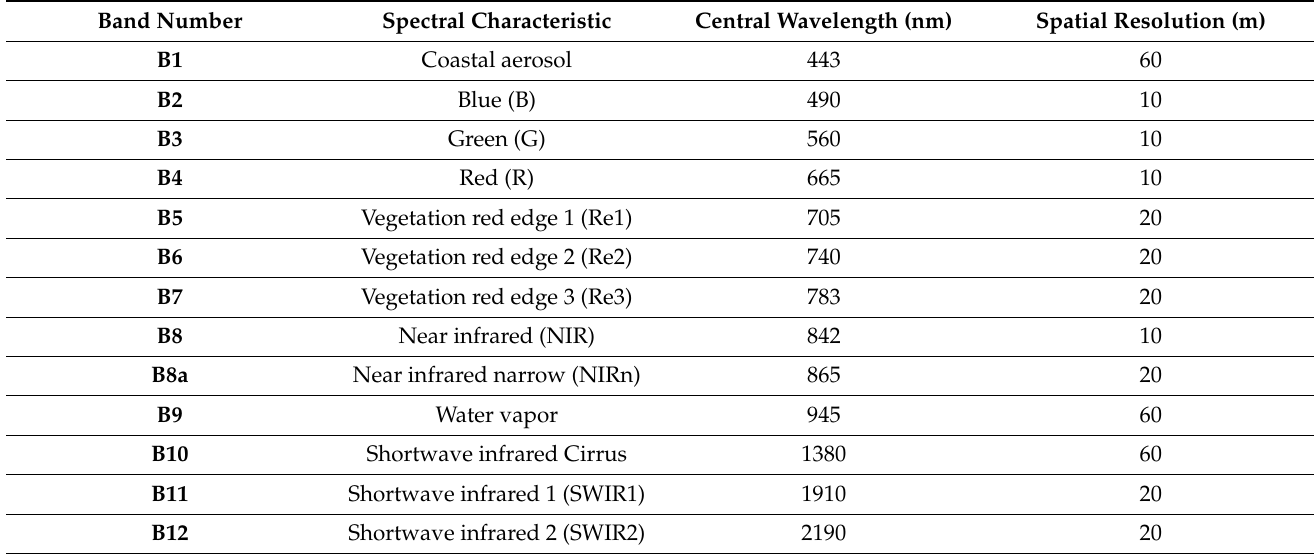
Table 1. Spectral and spatial characteristics of Sentinel 2A MSI.